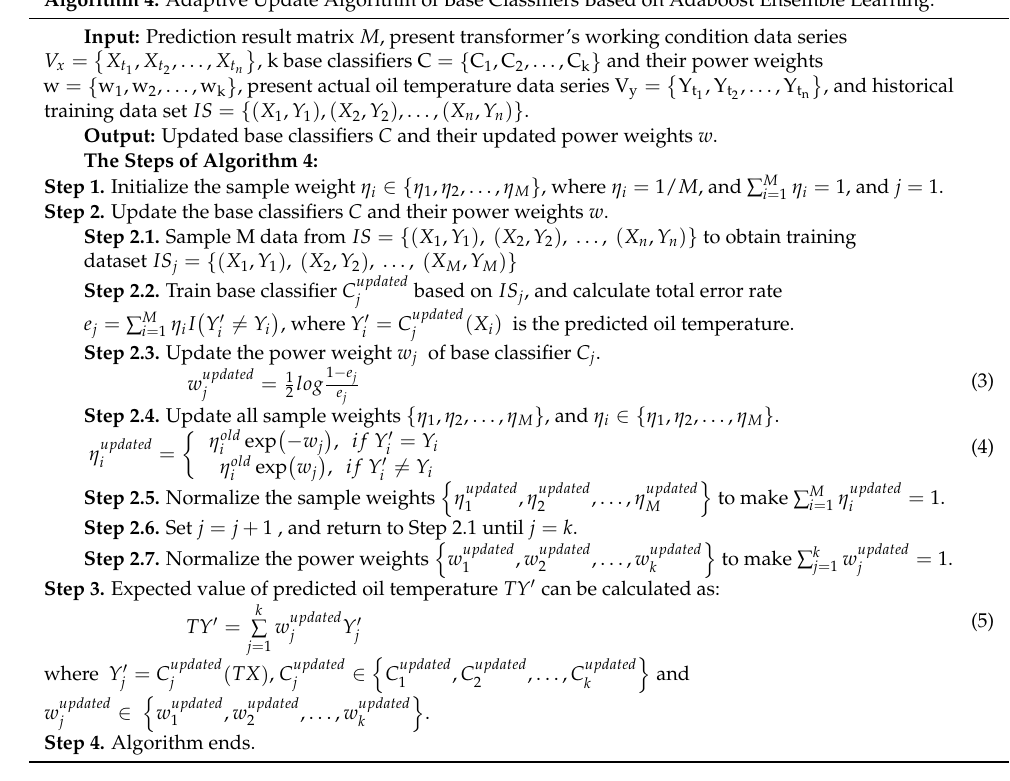
Algorithm 4. Adaptive Update Algorithm of Base Classifiers Based on Adaboost Ensemble